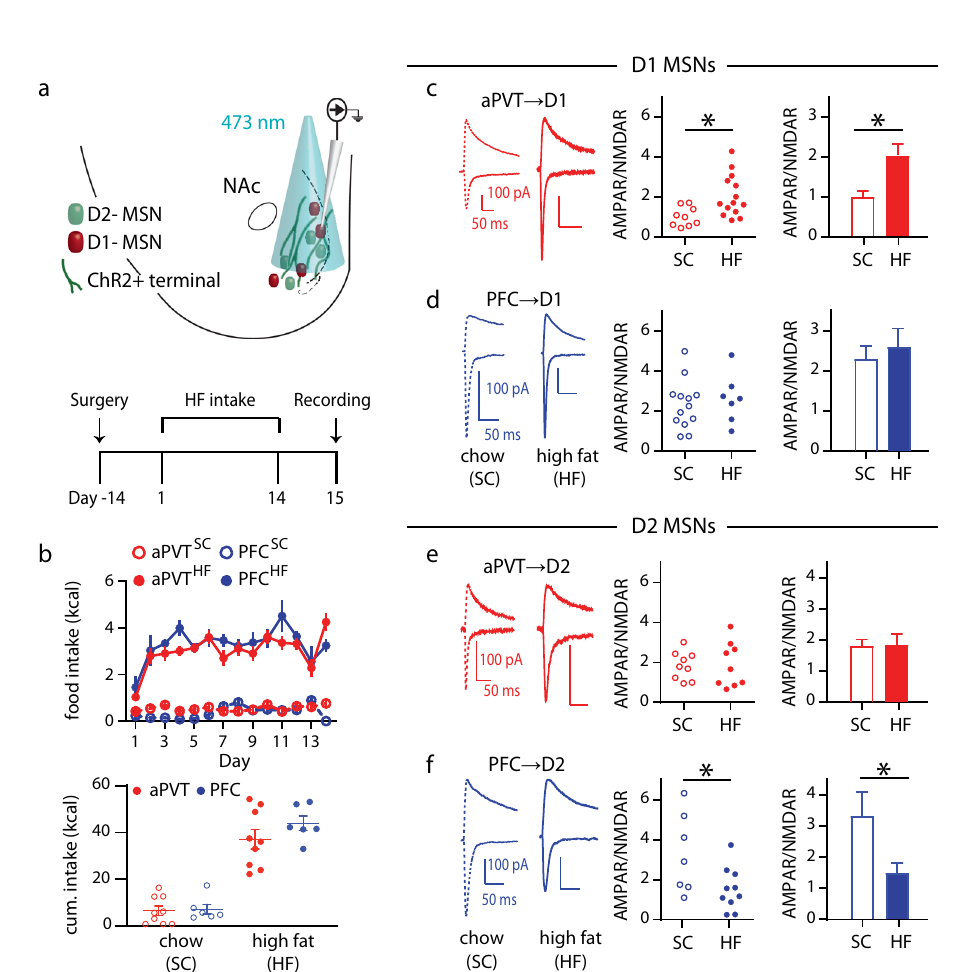
Fig. 5 Chronic high fat intake modi fi es MSN synaptic strength in an input- and cell type-speci fi c manner. a Schematic of experimental setup (top); experimental timeline (bottom). b (top) Daily intake of standard chow (SC) or high fat (HF) for mice expressing ChR2 in the PFC or aPVT; (bottom) Quanti fi cation of cumulative limited-access intake for PFC (n = 6/group) and aPVT mice ( n = 9/group). c , d Representative traces of mice exposed to SC versus HF (left). Quanti fi cation of AMPAR/NMDAR ratio in D1 MSNs for ( c ) aPVT ( t = 2.77, P = 0.01, n = 9, 14 cells/group, red) and ( d ) PFC ( n = 13, 7 cells/group, blue) inputs. e , f Representative traces of mice exposed to SC versus HF (left). Quanti fi cation of AMPAR/NMDAR ratio in D2 MSNs for ( e ) aPVT ( n = 9 cells/group, red) and ( f ) PFC ( t = 2.37, P = 0.03, n = 7, 10 cells/group, blue) inputs. Data are ±s.e.m. * P < 0.05, Student ’ s t test two-tailed. Source data are provided as a Source Data fi